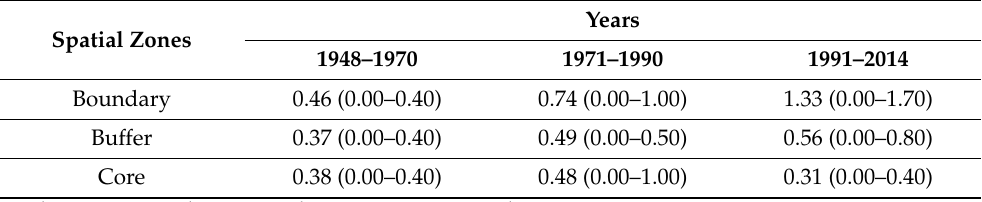
Table 2. The number of fires per compartment and decade in different zones of the Ilmensky Reserve in 1948–1970, 1971–1990, and 1991–2014